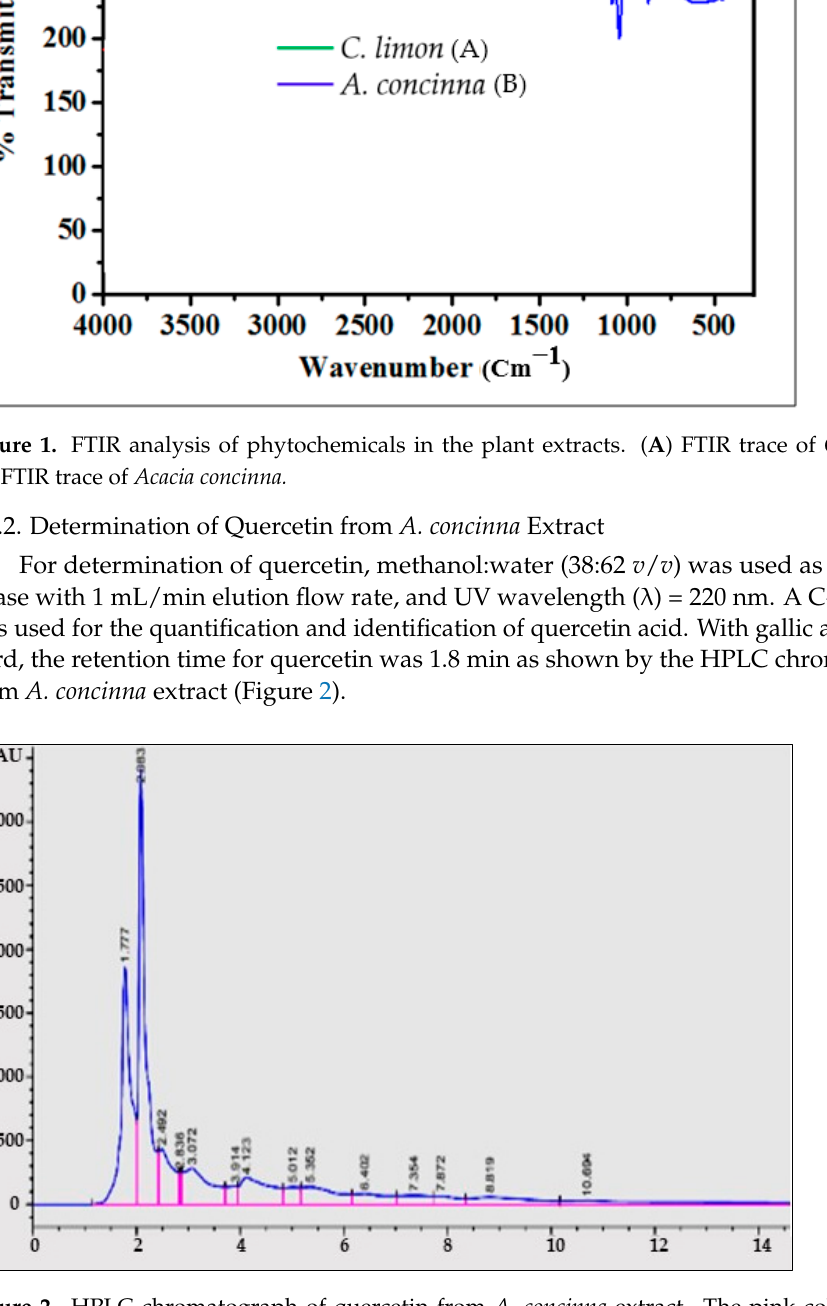
Figure 2. HPLC chromatograph of quercetin from A. concinna extract. The pink coloured lines represent the retention/peak values